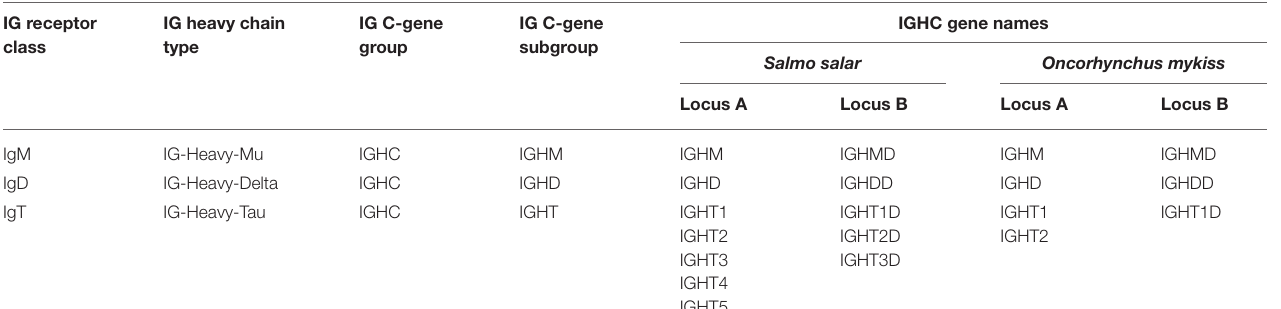
TABLE 1 | Salmonid IG receptor classes, heavy chain types, and IGHC gene